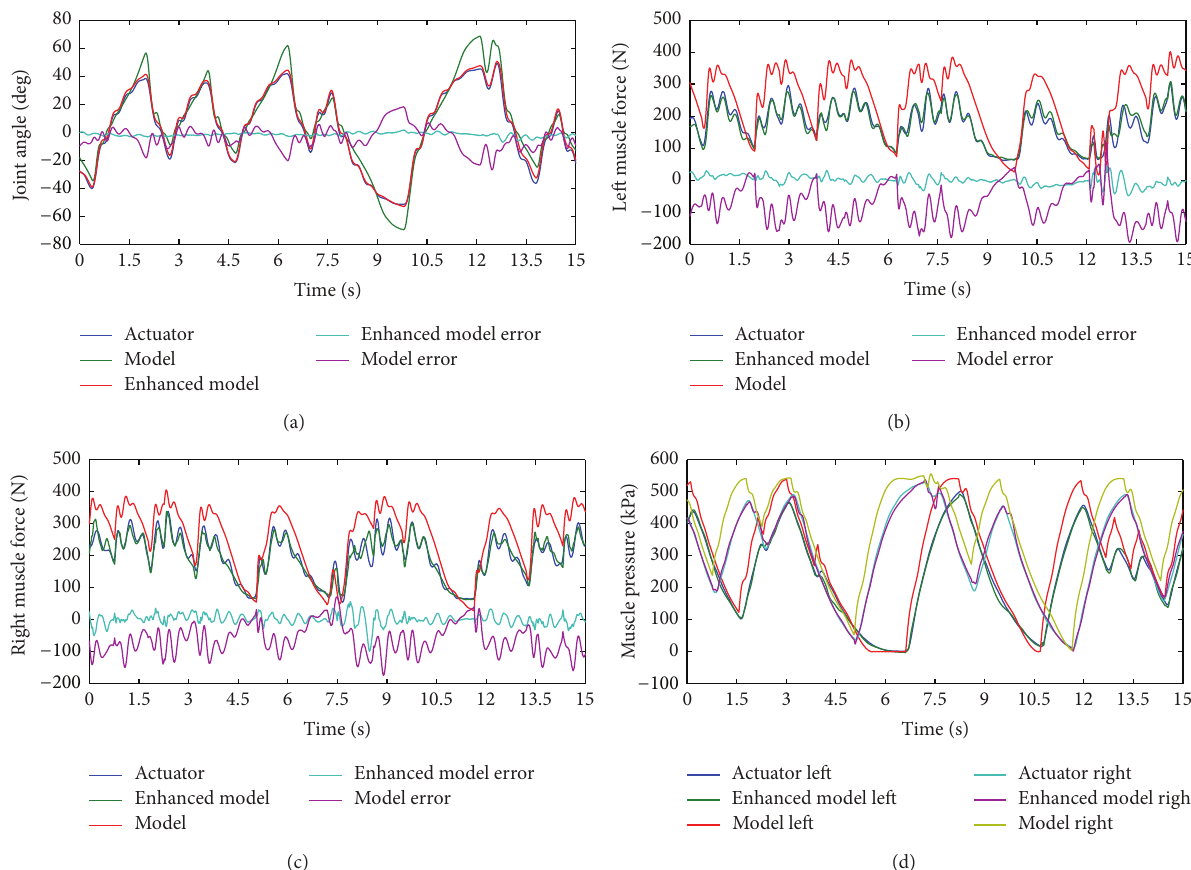
Figure 13: Comparison of model, enhanced model, and actuator generalization performance (test on unseen data with 11-multiple of nominal moment of inertia ((a) joint angle response, (b) left muscle force response, (c) right muscle force response, and (d) muscle pressure response in both